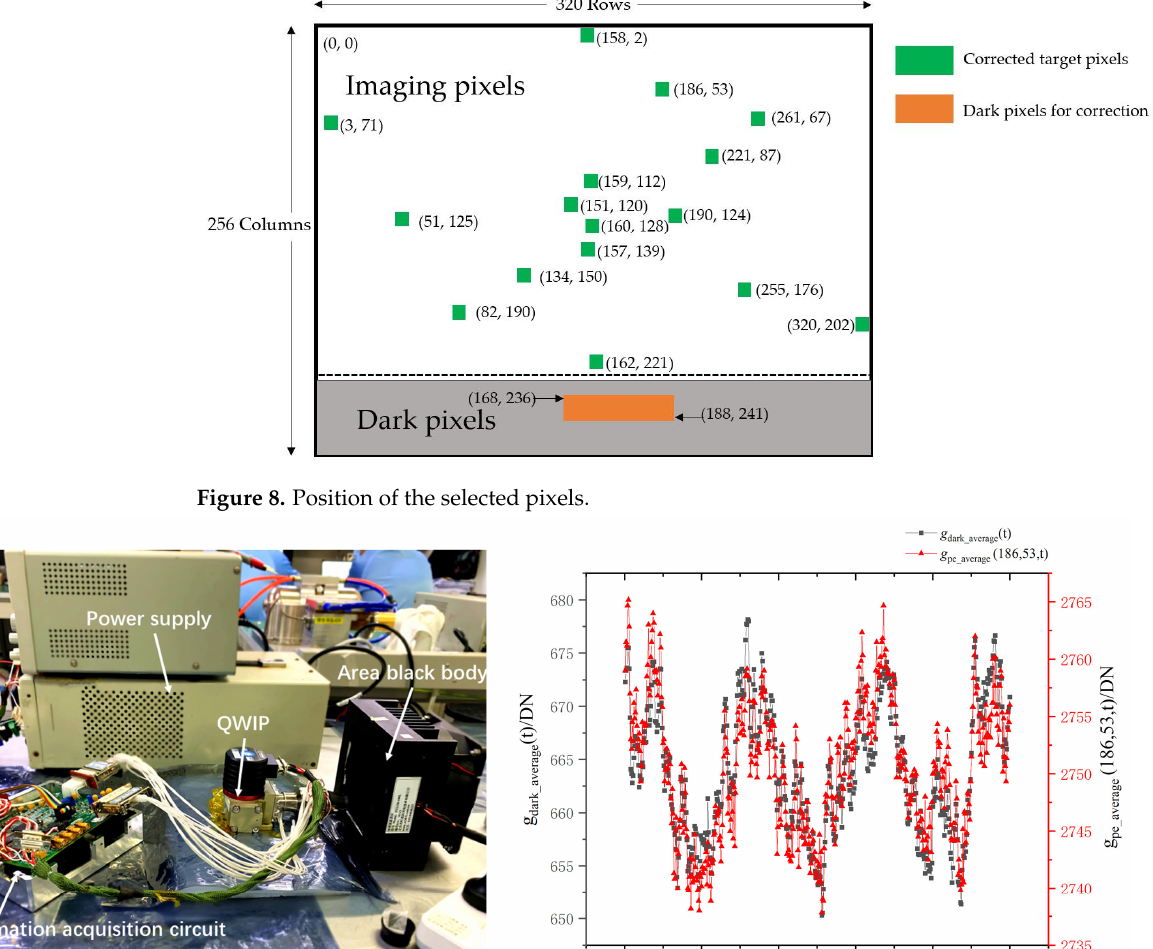
Figure 9. Characteristic data collection experiment: ( a ) device for collecting characteristic data; ( b ) characteristic data of dark pixels and imaging pixels.